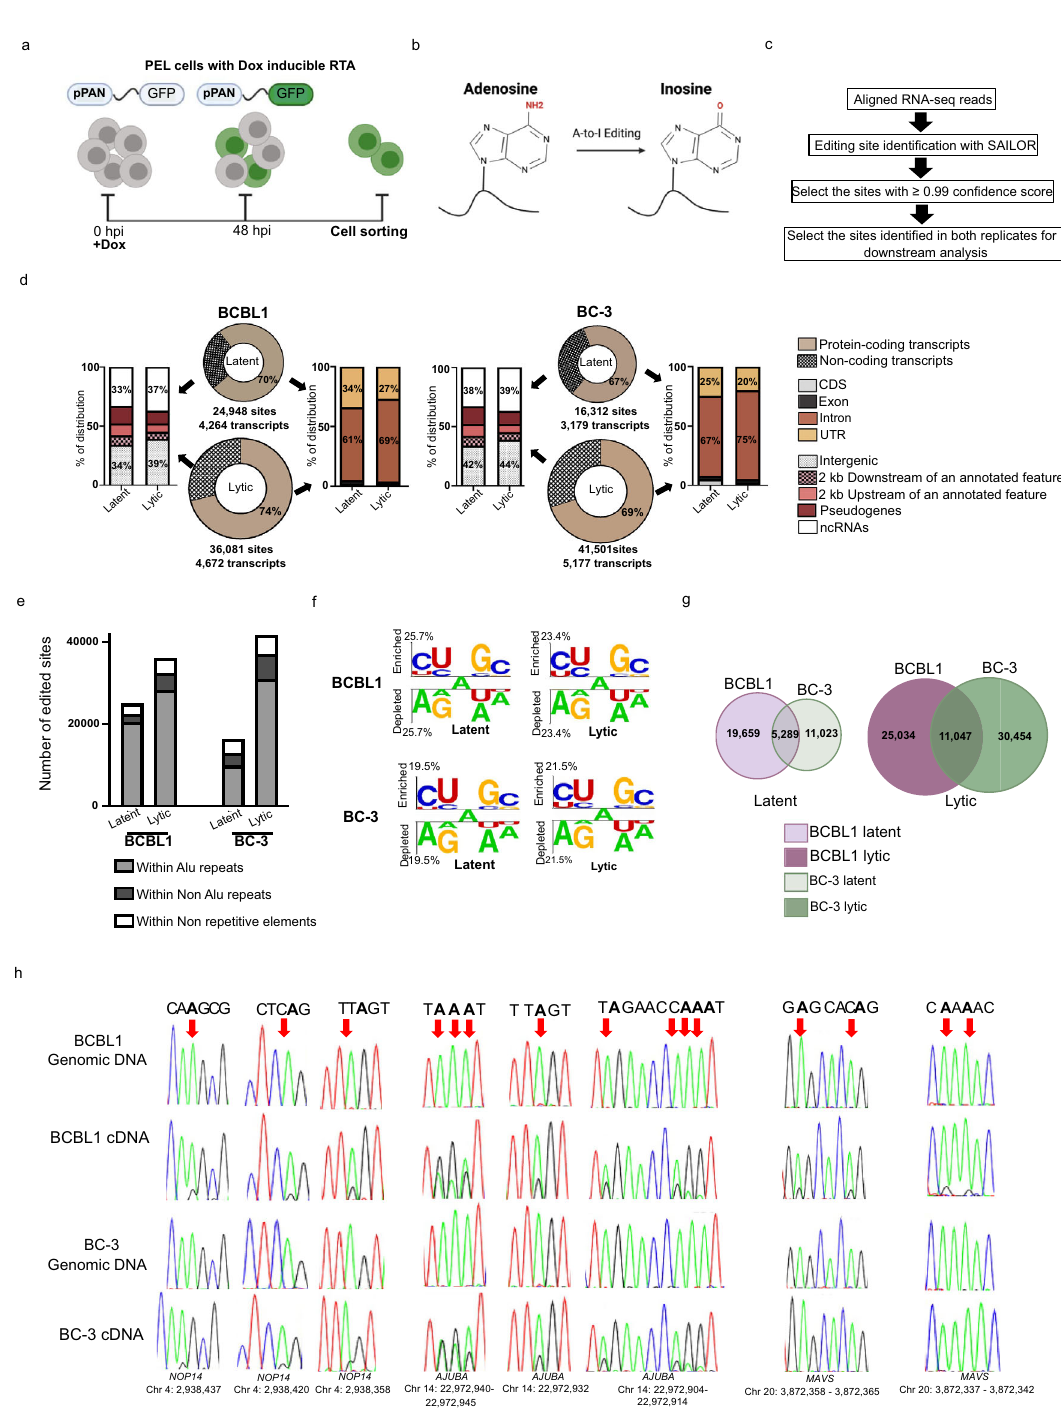
Fig. 1 | Global analysis of host A-to-I editing during the KSHV lifecycle. a Schematic representation of the strategy to isolate lytic PEL cells by FACS. Both PELcellshavetheintegrateddoxycycline(Dox)-inducibleversionofthemajorviral transcription activator RTA. Latent cells refer to the untreated PEL cells and lytic cellsrefertotheisolatedGFPpositivecellsat48hpi. b Schematicrepresentationof adenosine to inosine conversion by ADARs. c A-to-I editing analysis pipeline. d Genomic distribution of edited sites in BCBL1 (left) and BC-3 (right) cells. Donut charts represent the percentage of edited sites mapped to protein-coding tran- scripts and non-coding transcripts. Sites mapped to protein-coding transcripts were further divided based on the location on the transcript (coding sequence (CDS),exons,intronsanduntranslatedregions(UTR)).Sitesmappedtonon-coding